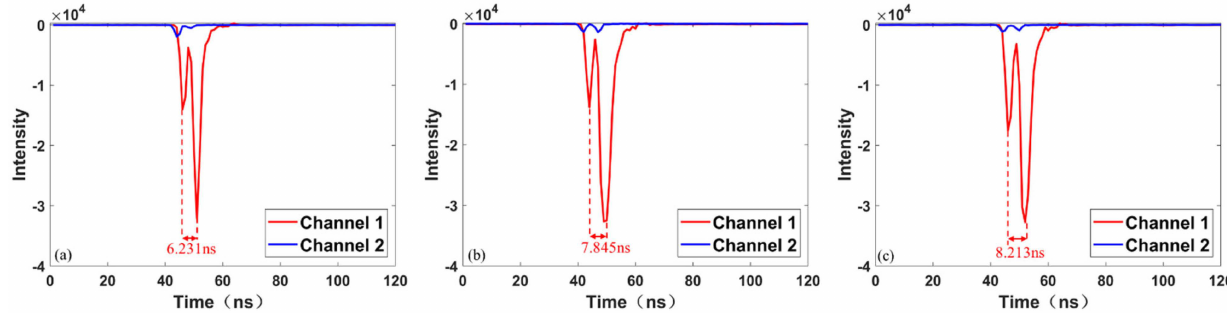
Figure 27. The waveform received under the water pond environment.